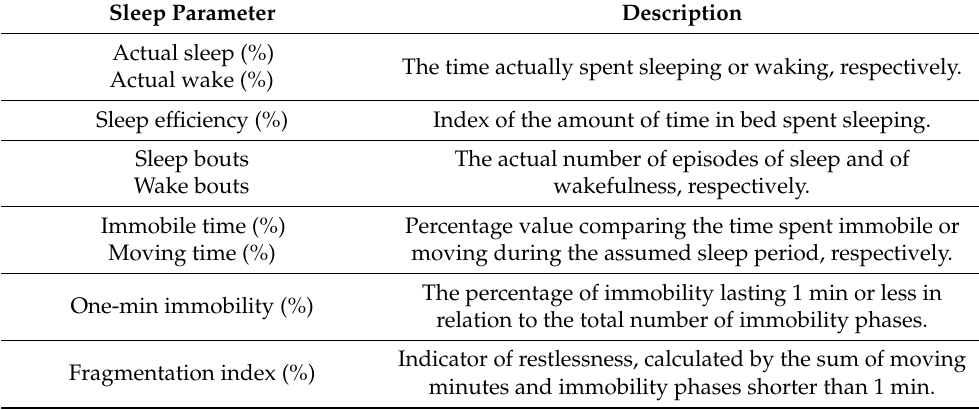
Table 2. Description of presented sleep parameters according to the Actiwatch user manual V 7.2 and [20].